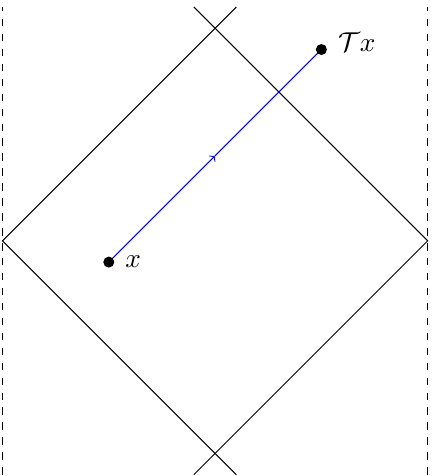
Figure 4. The contour prescription for the light-transform. The contour starts at x 2 M d and moves along the z direction to the point x + = T x in the next Poincare patch T M d